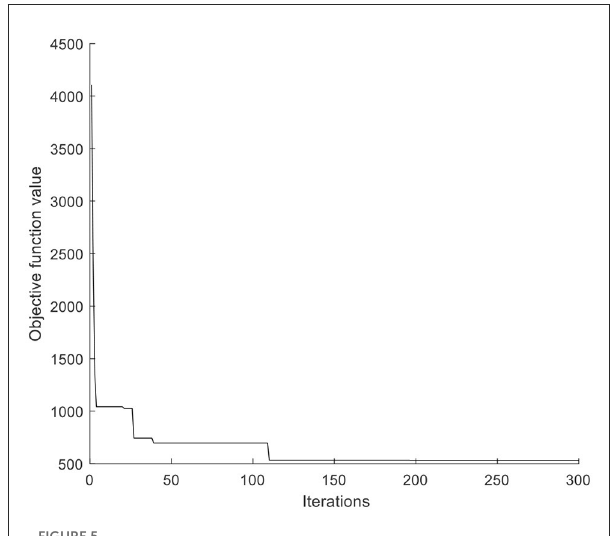
FIGURE5 The convergence diagram of